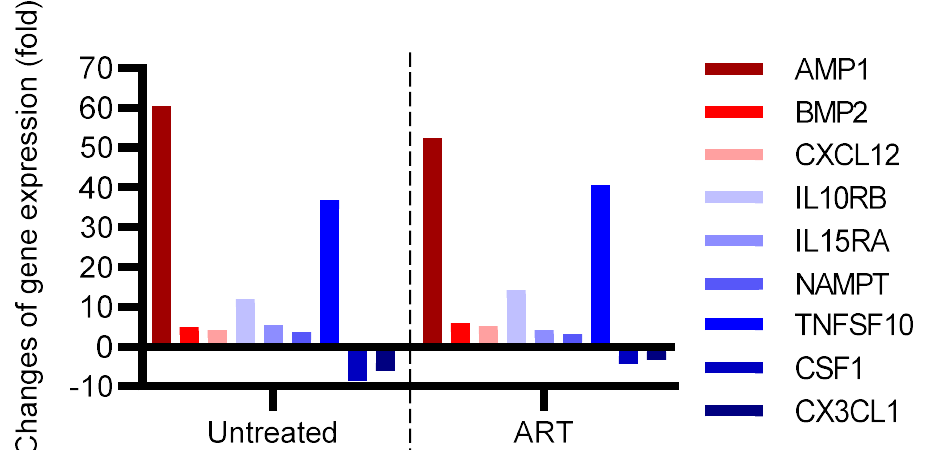
Figure 5. Profiling of gene expression in the basal ganglia of SIV + chRMs with antiretroviral therapy (ART) or without ART (Untreated). The fold-changes of gene expression in the ART and Untreated groups were shown separately in comparison with the healthy control group. Table 1. Gene expression fold change and p-value for each experimental group against the control group.